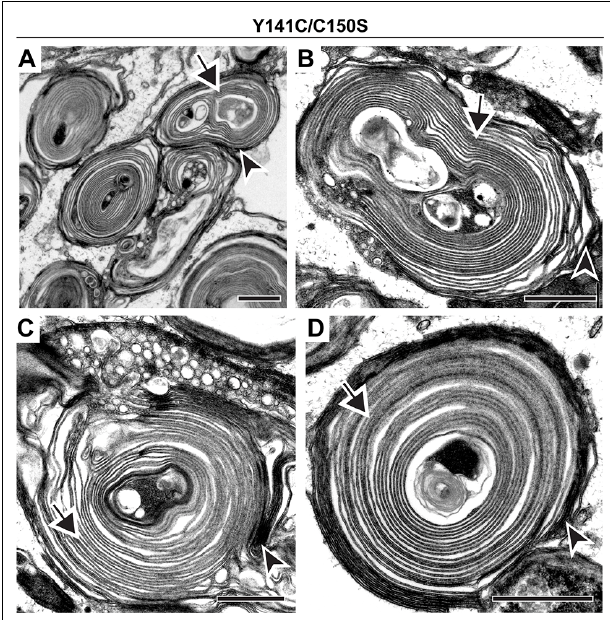
FIGURE 6 | Co-expression of Y141C and C150S PRPH2 disrupts outer segment structure without preventing disc enclosure. (A–D) TEM of photoreceptor outer segments of 30-day old compound heterozygous Y141C/C150S mice stained with tannic acid. For each genotype, over 100 different outer segments from two mice were analyzed. For all images, arrowheads mark darkly stained open discs while arrows mark lightly stained enclosed discs. Scale bars are 1 µ